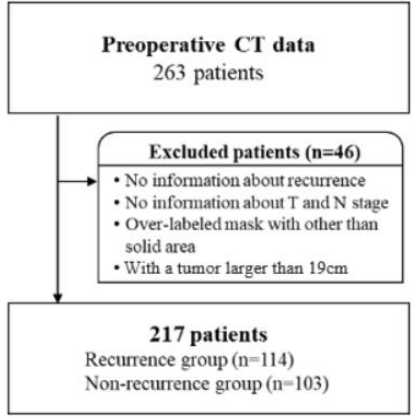
Figure 3. The criteria of patient selection.